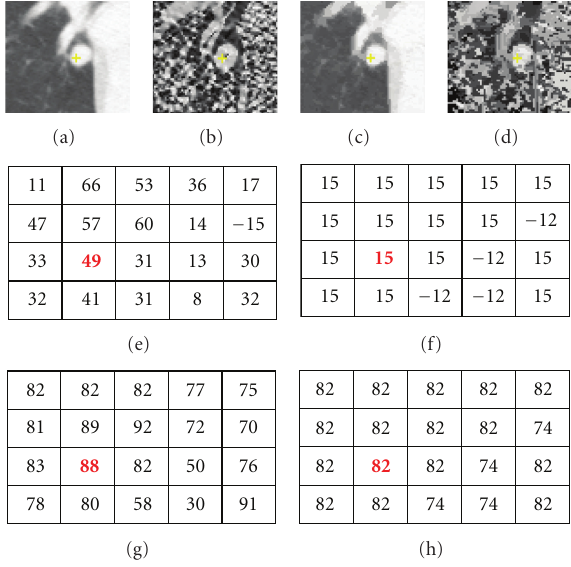
Figure 2: An attached nodule with its intensity and shape mode maps. (a) Original CT subimage; (b) shape index map based on (1); (c) and (d) intensity mode and shape index mode maps; (e)– (h) intensity values, intensity mode values, shape index values, and shape index mode values at the same voxel in the nodule. (It is noted that shape index are values multiplied by 100.)